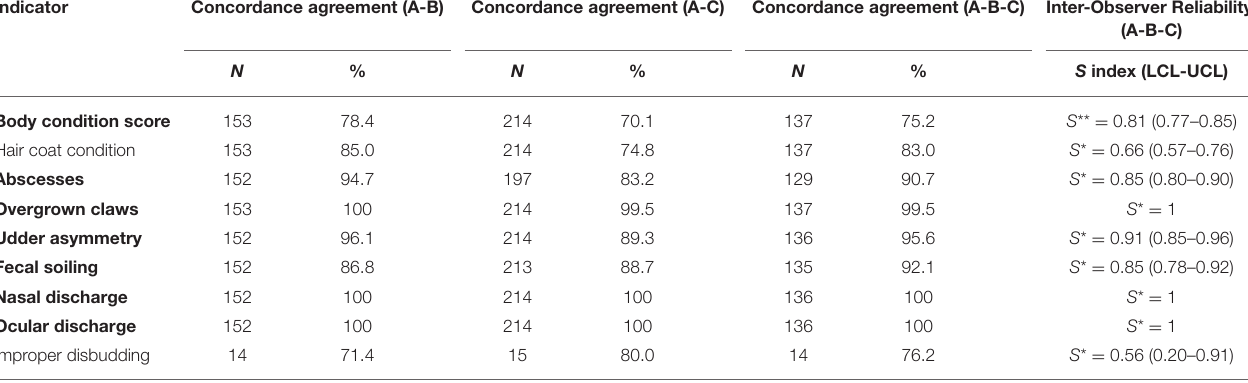
TABLE 3 | Inter-observer reliability for individual-level observations.